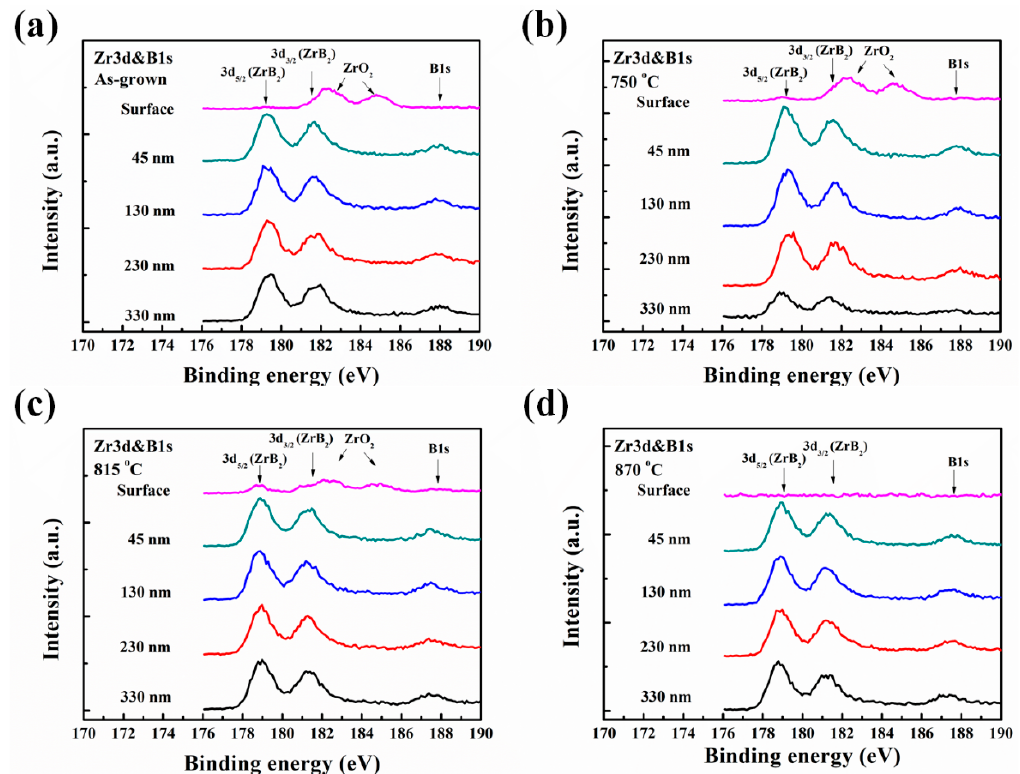
Figure 5. The Zr 3 d and B 1 s regions in the XPS spectra of the ( a ) as-grown ZrB 2 film and ZrB 2 films annealed at ( b ) 750 °C, ( c ) 810 °C, and ( d ) 870 °C.